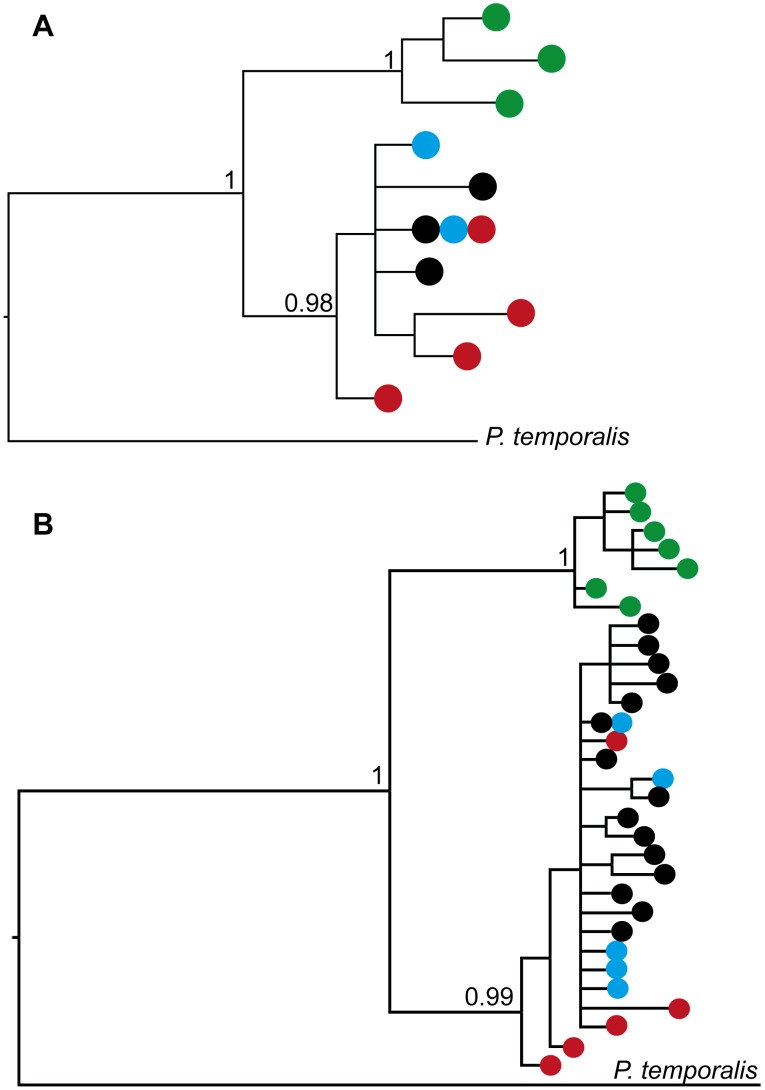
Clade structure for P. superciliosus inferred from Bayesian phylogenetic analysis.Bayesian consensus trees reconstructed from ND3 and domain I sequences showing posterior probabilities of the major nodes. Coloured circles at the branch tips denote the presence of that haplotype in each of the named subspecies; P. s. gilgandra (green), P. s. superciliosus (black), P. s. centralis (red) and P. s. ashbyi (blue). Colour-coded as in Figures 1 and 2.